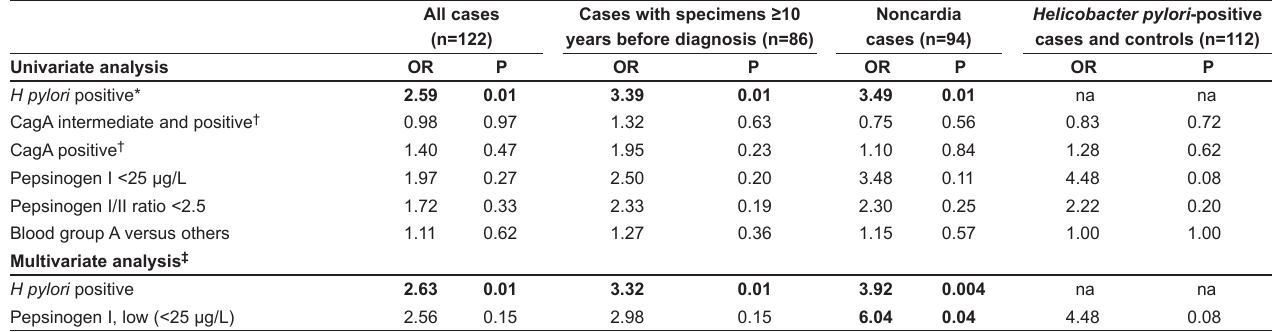
TAble 2 Gastric cancer predictors according to case group